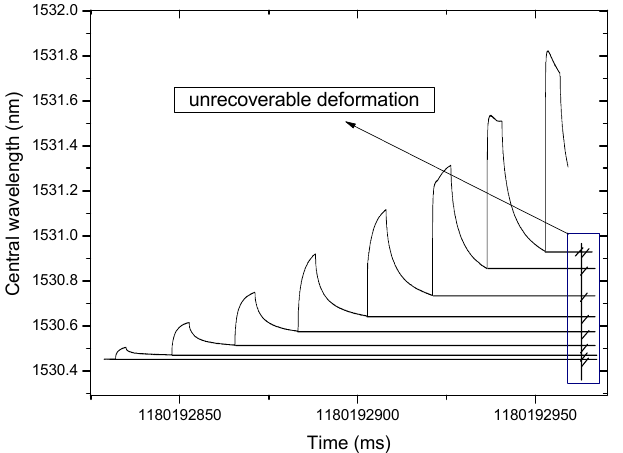
Figure 16. Static load experiment monitoring results of PP-OFBG strain